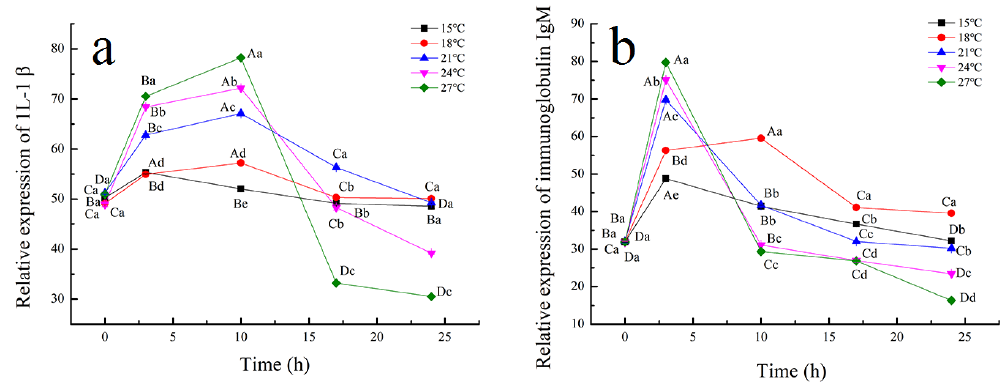
Figure 4. Effect of temperature on relative expression of 1L-1β ( a ) and IgM ( b ) of tiger grouper during simulated transport. Among different temperature transport groups, different small and capital letters indicate the results of Duncan’s test at different transport time. The same letters mean no significant difference ( p > 0.05), while different letters mean significant difference ( p < 0.05). Different letters without * = p- value < 0.05, different letters with ** = p- value < 0.01.